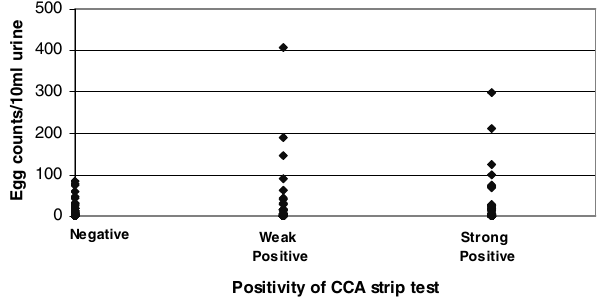
Fig. 1. – Association of CCA strip test results with infection inten- sity of urinary schistosomiasis expressed as egg counts per 10 ml of urine sample.